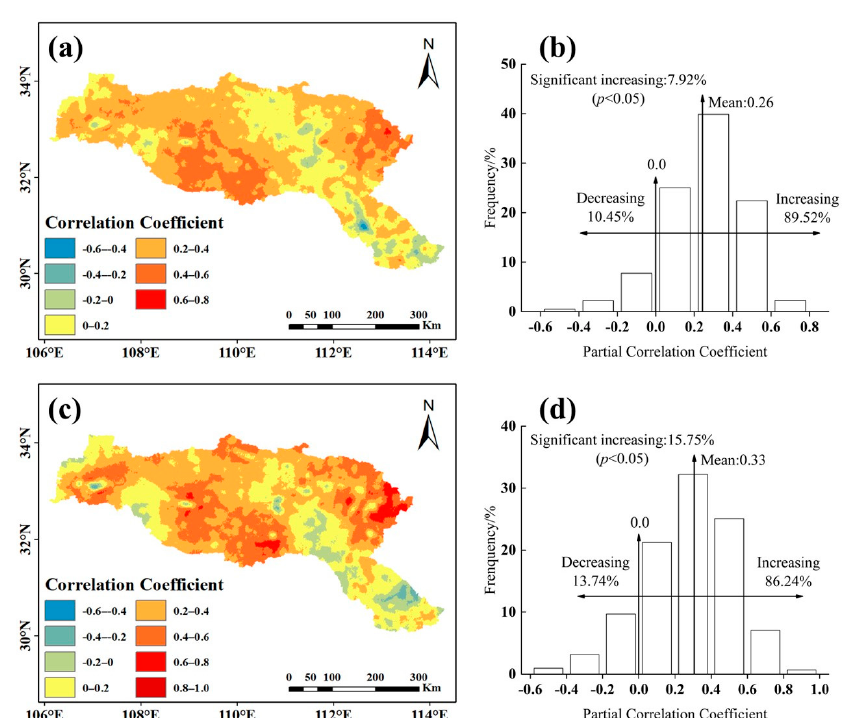
Figure 7. Relationships between NDVI and climate factors: ( a ) the relationship between NDVI and the precipitation, ( b ) the distribution of partial correlation coefficient between NDVI and the precipitation, ( c ) the relationship between NDVI and the temperature, ( d ) the distribution of partial correlation coefficient between NDVI and the temperature.